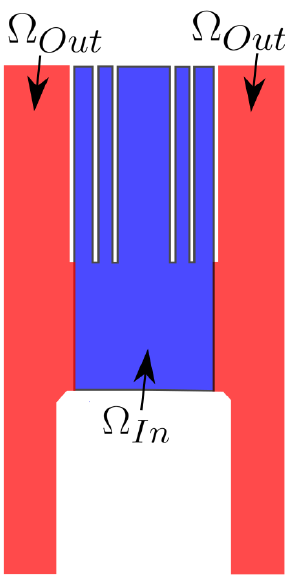
Figure 2. Definition of the inner part Ω In and the outer part Ω Out in the down-flow